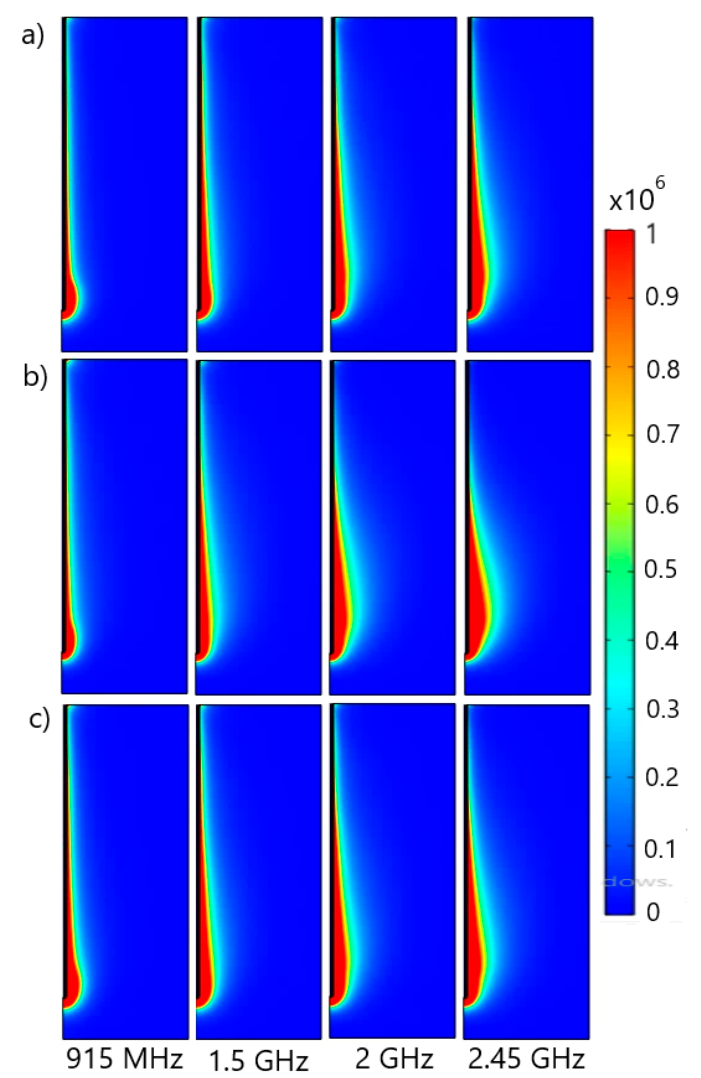
Figure 3. The total power dissipation density (expressed in W/m 3 ) is calculated using the dielectric properties of ( a ) inflated lungs [52], ( b ) deflated lungs [52], and ( c ) constant permittivity and conductivity values [53,54] at microwave frequencies ranging from 915 MHz to 2.45 GHz. Temperature profiles follow the heat-source distributions as observable from 3D (Figure 4) and 2D (Figure 5) plots, showing the steady-state temperature distributions in the lung tissue achieved after t = 600 s. The absorbed energy converted into thermal energy causes an increase in the tissue temperature. Whether respiration is taken into account or not, the temperature distribution is near ellipsoidal around the slot, reaching the highest values near the microwave antenna slot. As the distance from the antenna increases, the heat source becomes weaker, so the blood can maintain the tissue at a normal body tem- perature. It appears that the perfusion of blood limits the extent of the heated area.